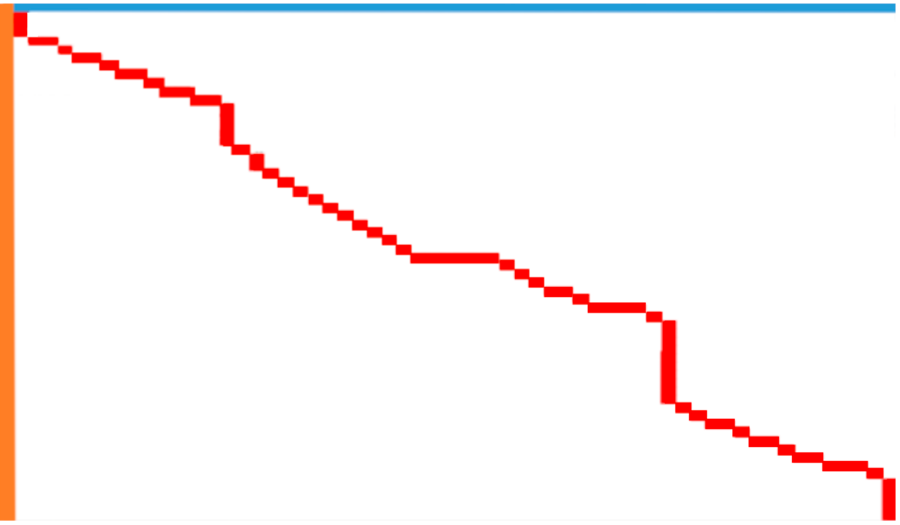
Figure 9. Dynamic warping path marked in red between the template data, marked in blue, and the user data, marked in orange.